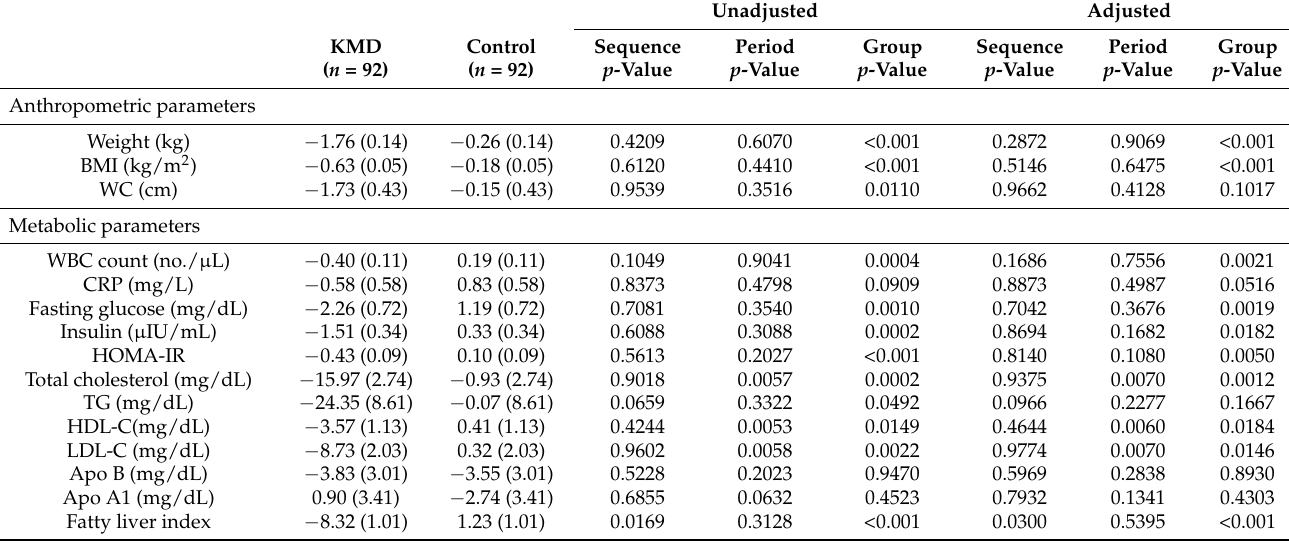
Table A1. Comparison of changes in metabolic parameters according to diet type.